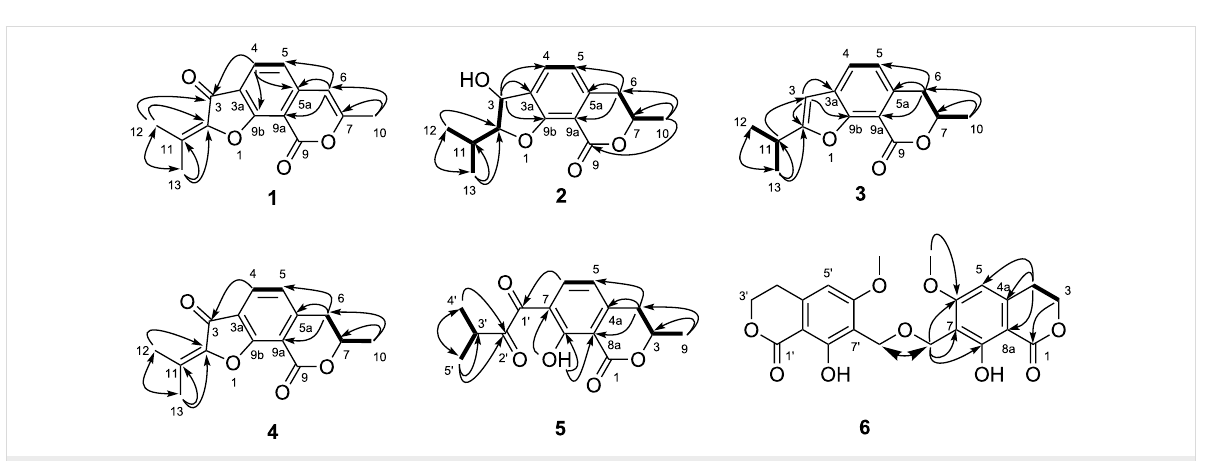
a1 H (400 MHz) and 13 C (100 MHz) in CDCl 3 .